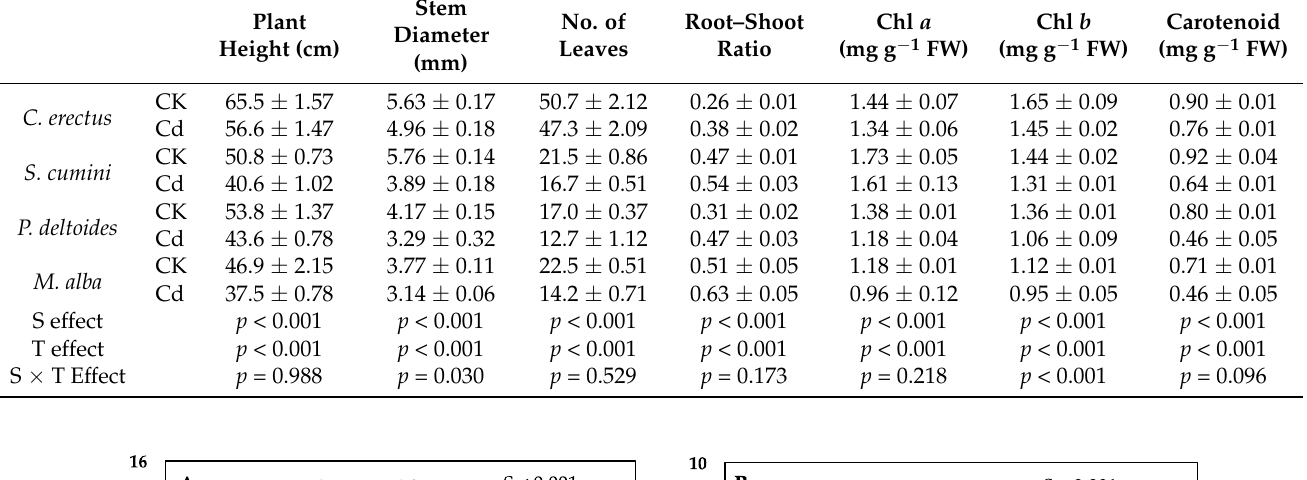
Table 1. Means ± SE for growth traits and chl a, b and carotenoid contents in four tree species under CK and Cd treatments. Small letters depict significant differences between treatment means (n = 5).